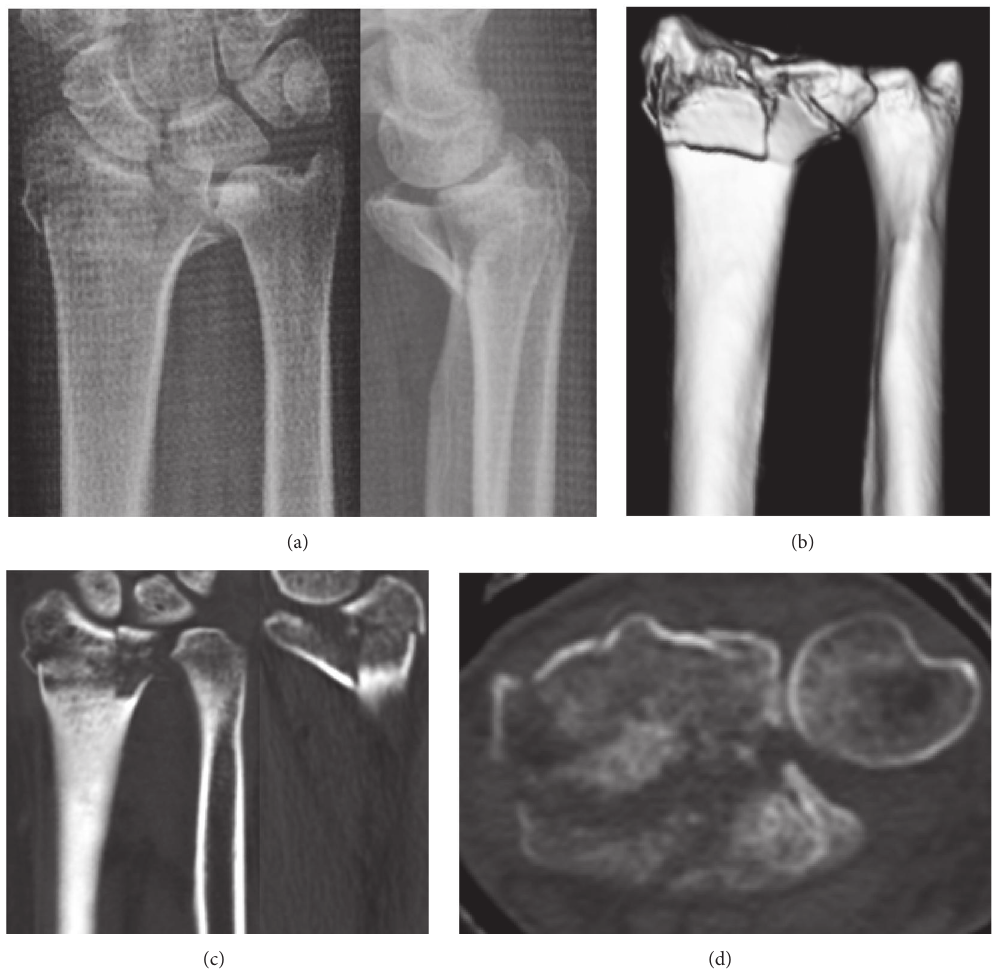
Figure1: Patient 1. Plainradiographs (a) and CT(b, c, d) at thetimeof injury. A 10 × 8 mmVLF fragment isobserved, with volar displacement.